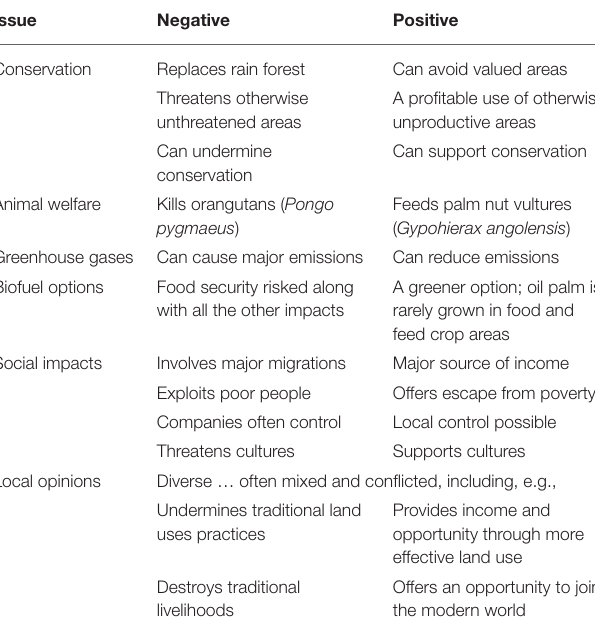
TABLE 2 | Examples of distinct viewpoints on different aspects of oil palm depend on who you ask and on how the question is